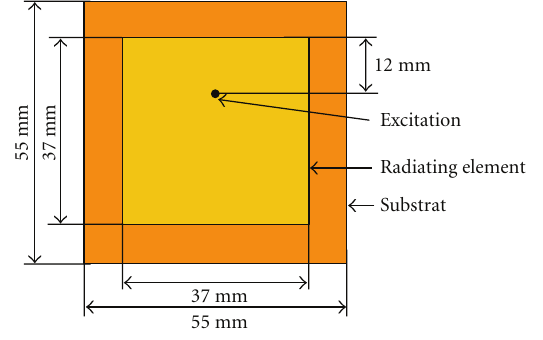
Figure 3: Patch antenna dimensions.